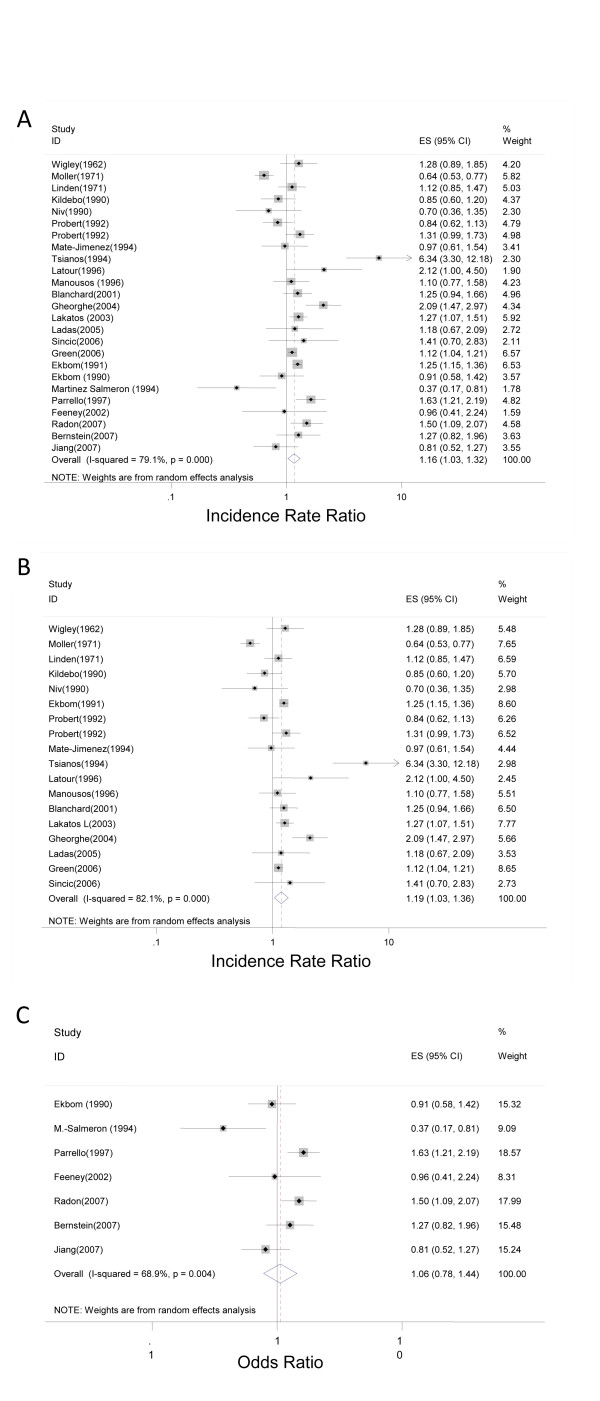
Forest plot of the summary effect estimate with 95% CI studies that explored the relationship between urban environment and ulcerative colitis for both cohort and case–control studies (A); cohort studies (B); and case–control studies (C).